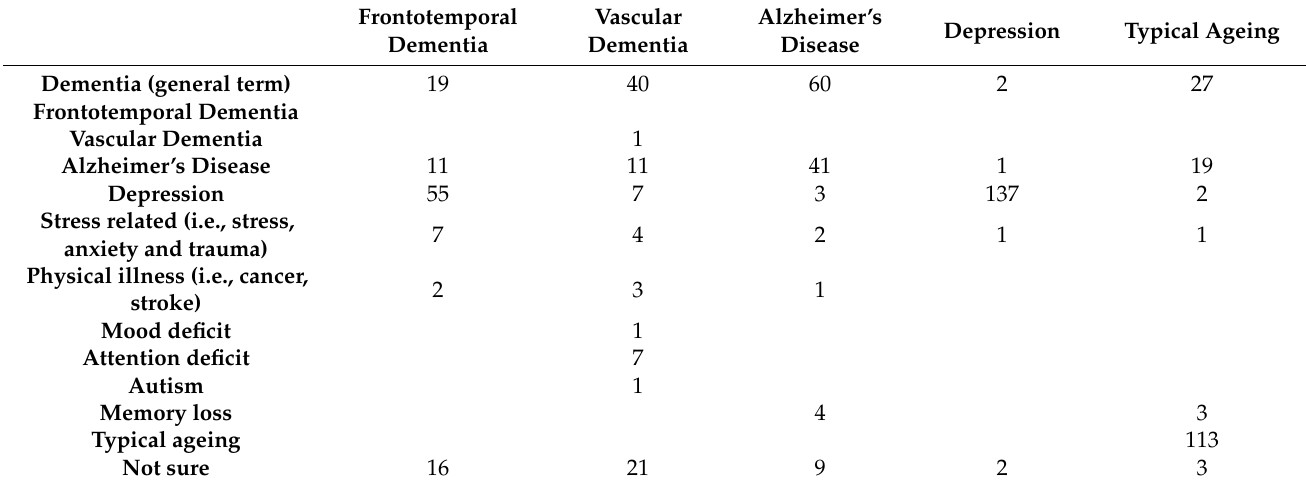
Table 2. Responses to each vignette.